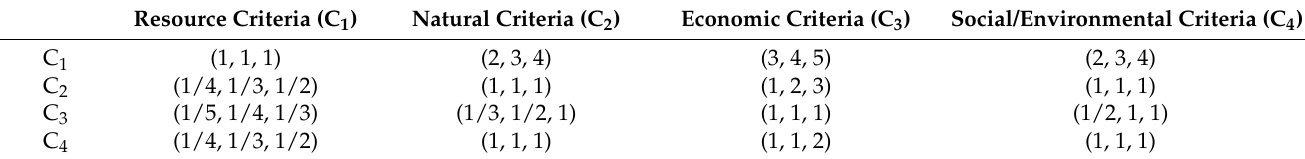
Table A3. Fuzzy pairwise comparison matrix of expert 3 (Weight: 0.2).